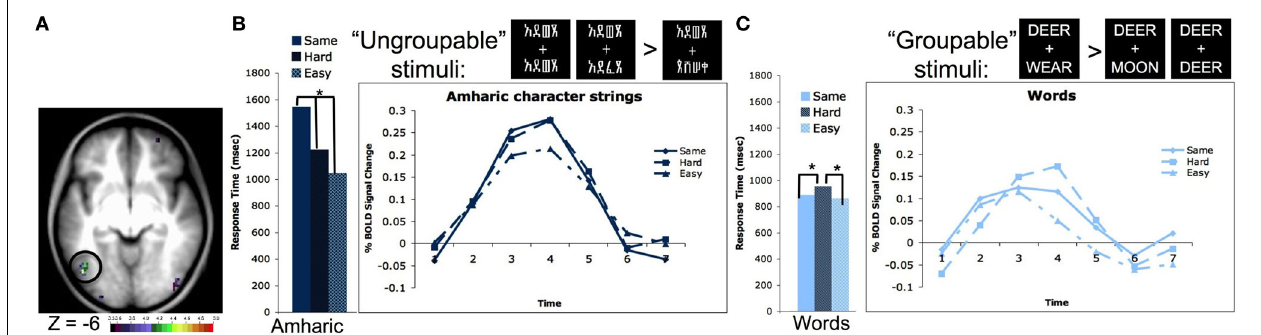
FIGURE 2 | The left OT processes unfamiliar stimulus strings as individual characters and familiar strings as groups of characters. (A) Location of the left OT region defined in a whole brain pair type by timecourse analysis ( − 44, − 67, − 4 in MNI coordinates). (B) Reaction times and timecourses of BOLD activity for Amharic character pairs that are all the same, 2 character different hard pairs, and 4 character different easy pairs. The RTs and BOLD activity increase with the number of characters that must be evaluated to make a matching decision, indicating character by character processing. Asterisks denote RT values that have differences with p < 0 . 05.